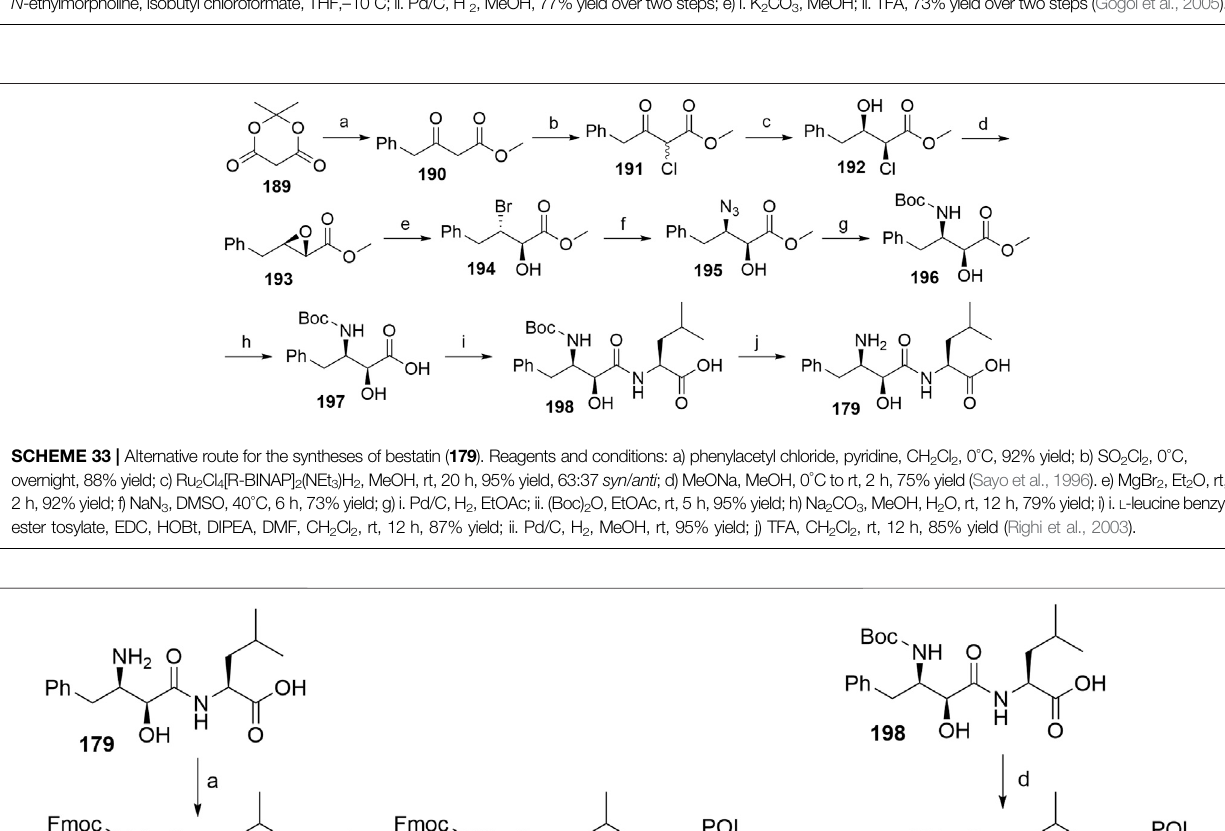
Frontiers in Chemistry |